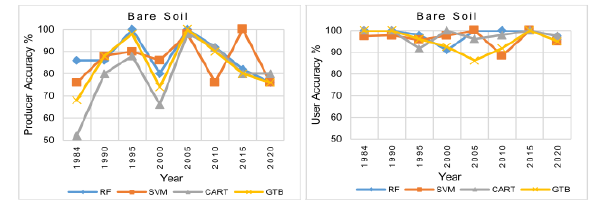
Figure 8 . PA and UA results for mapping of bare-soils.